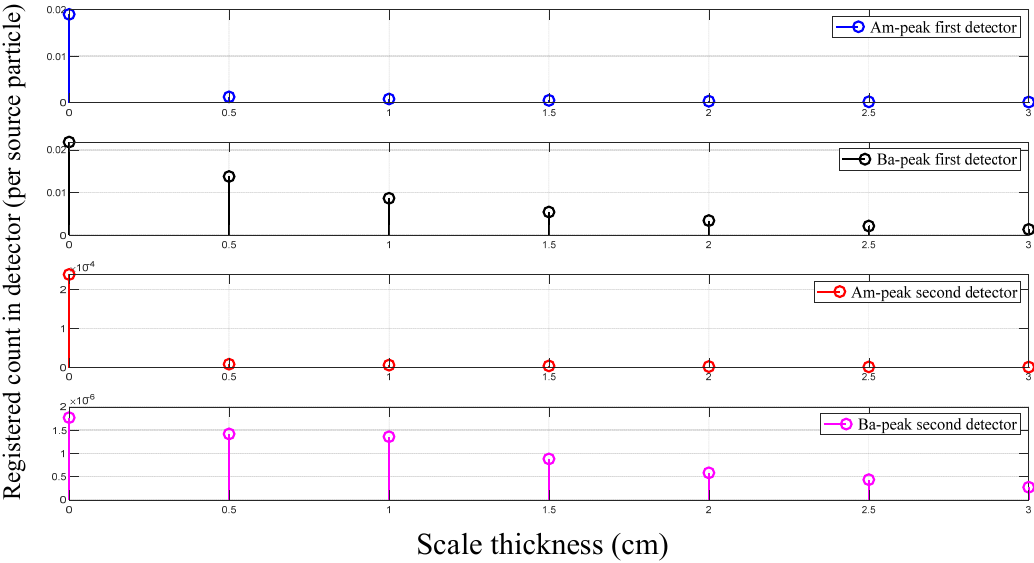
Figure 3. Recorded counts under Photopeaks of ( a ) 241 Am and ( b ) 133 Ba radioisotope in the second detector for different combined oil, gas and water volume fractions at thickness scale of 1.5 cm.